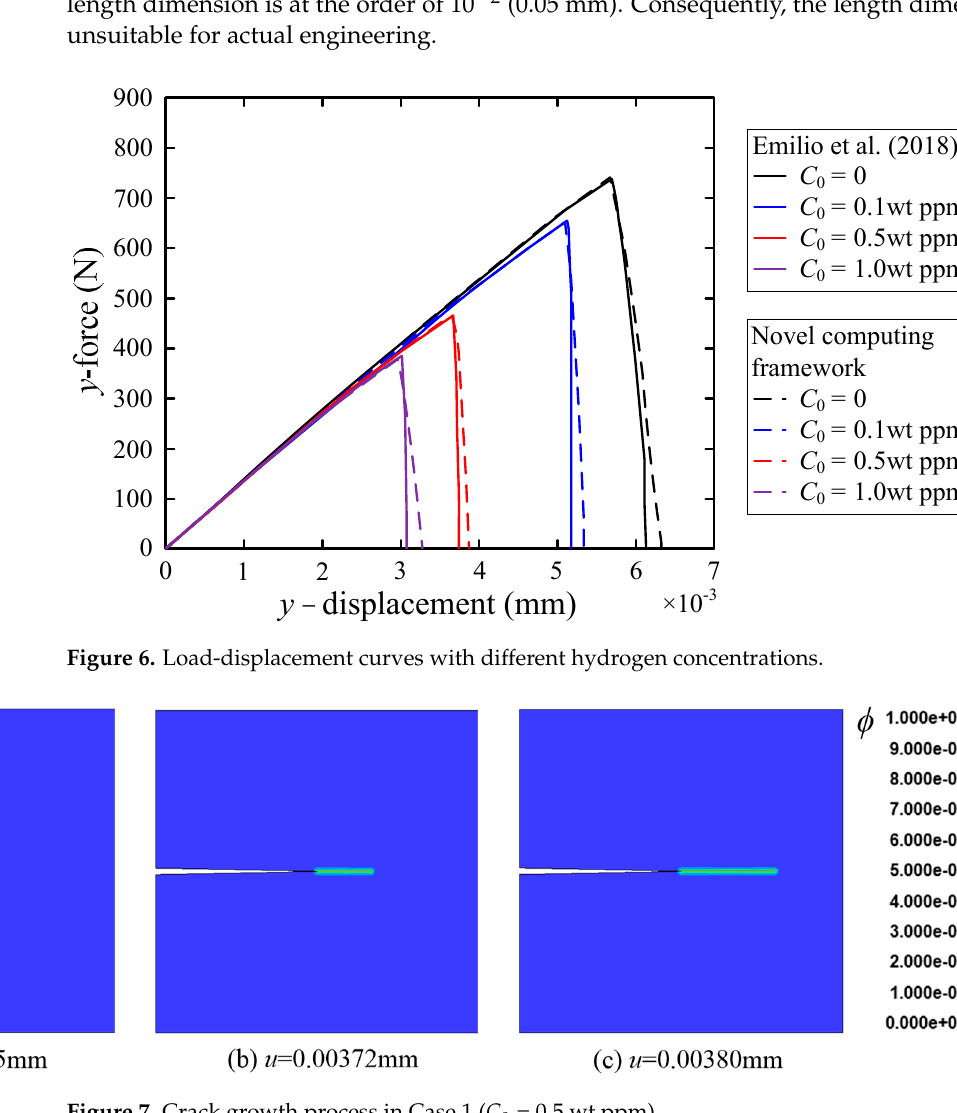
(b) Mesh Figure 5. Model diagram of Case 1. Table 1. The parameter values in Case 1. Parameter